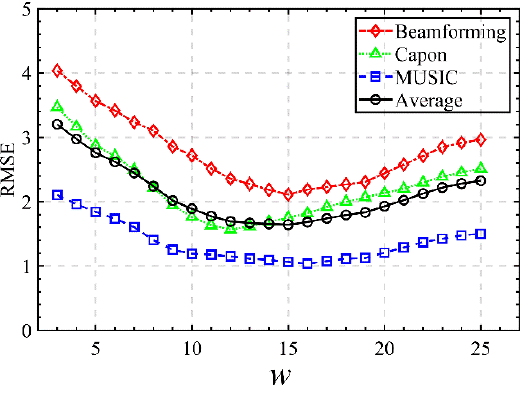
Figure 6. The effect of the search window size w on the RMSE.